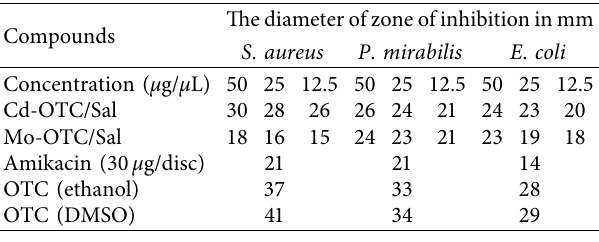
Table 3: Antibacterial growth data of Cd-OTC/Sal and Mo-OTC/ Sal metal complexes. The diameter of zone of inhibition in mm Compounds